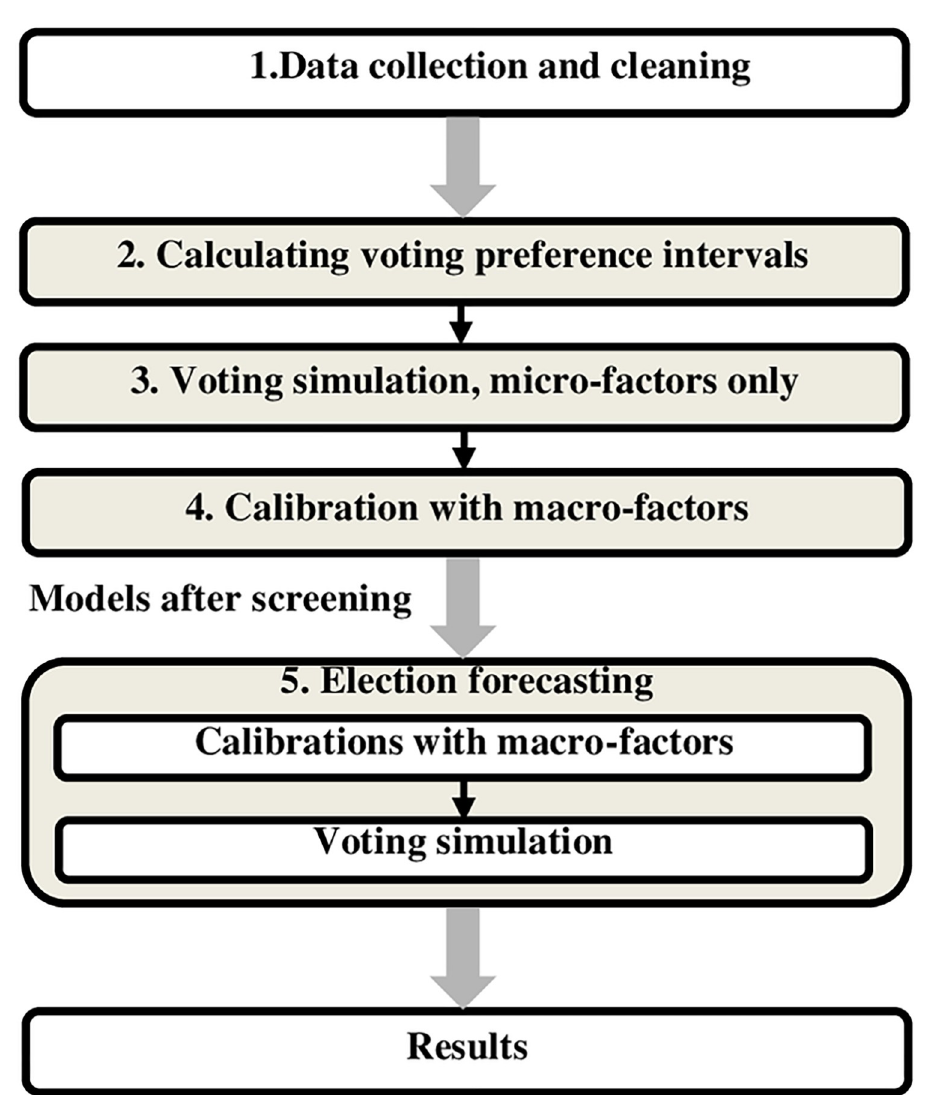
Fig 1. Forecasting elections with ABM